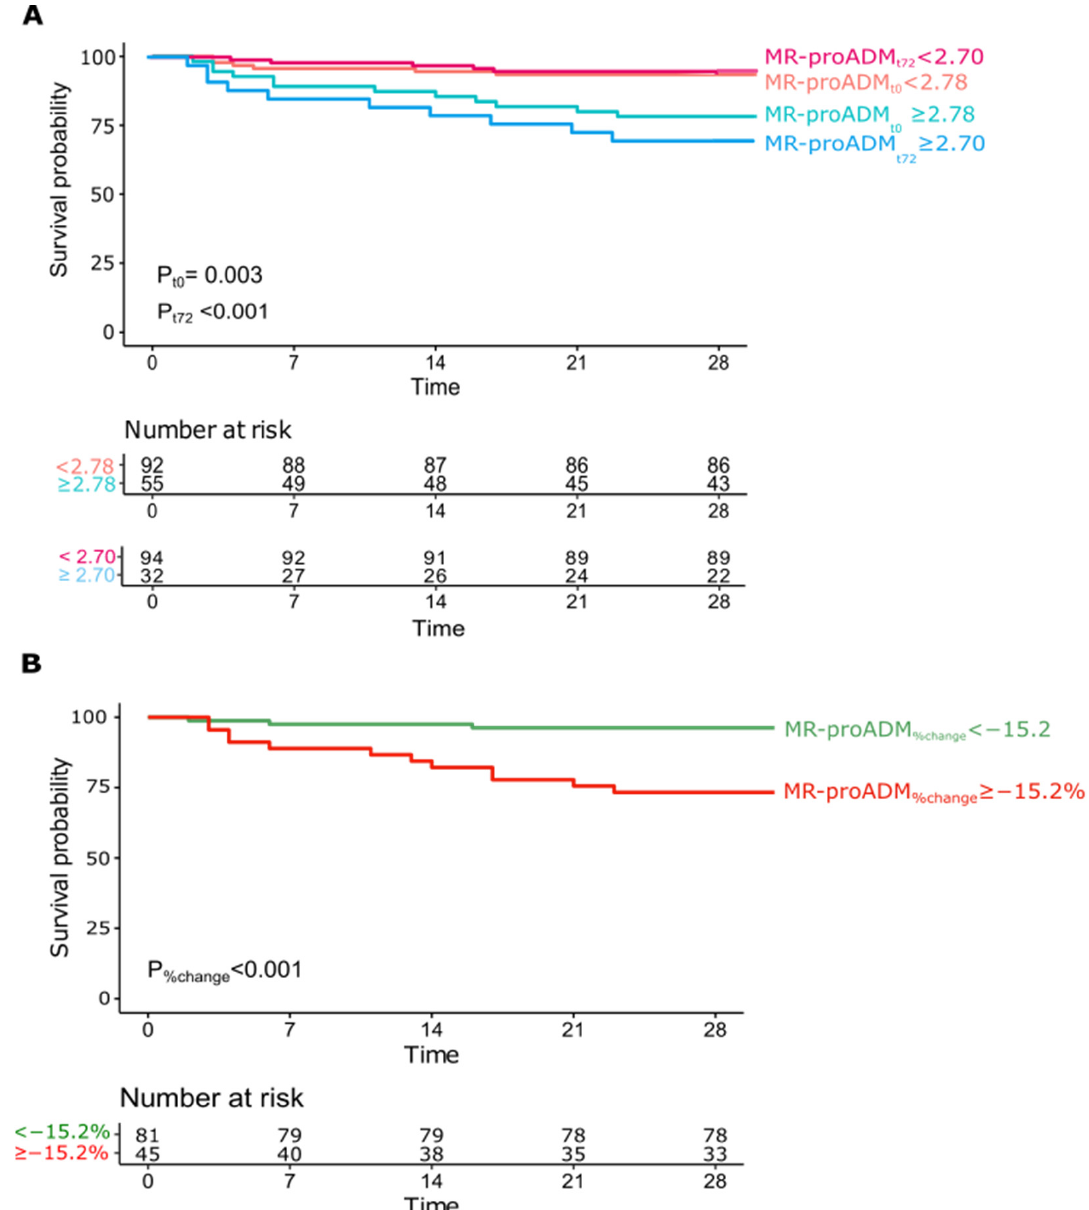
Figure 3. Kaplan–Meier estimator curves for MR-proADM t0 ≥ 2.78 and MR-proADM t72 ≥ 2.70 (panel ( A )), and MR-proADM %change ≥− 15.2% (panel ( B )).